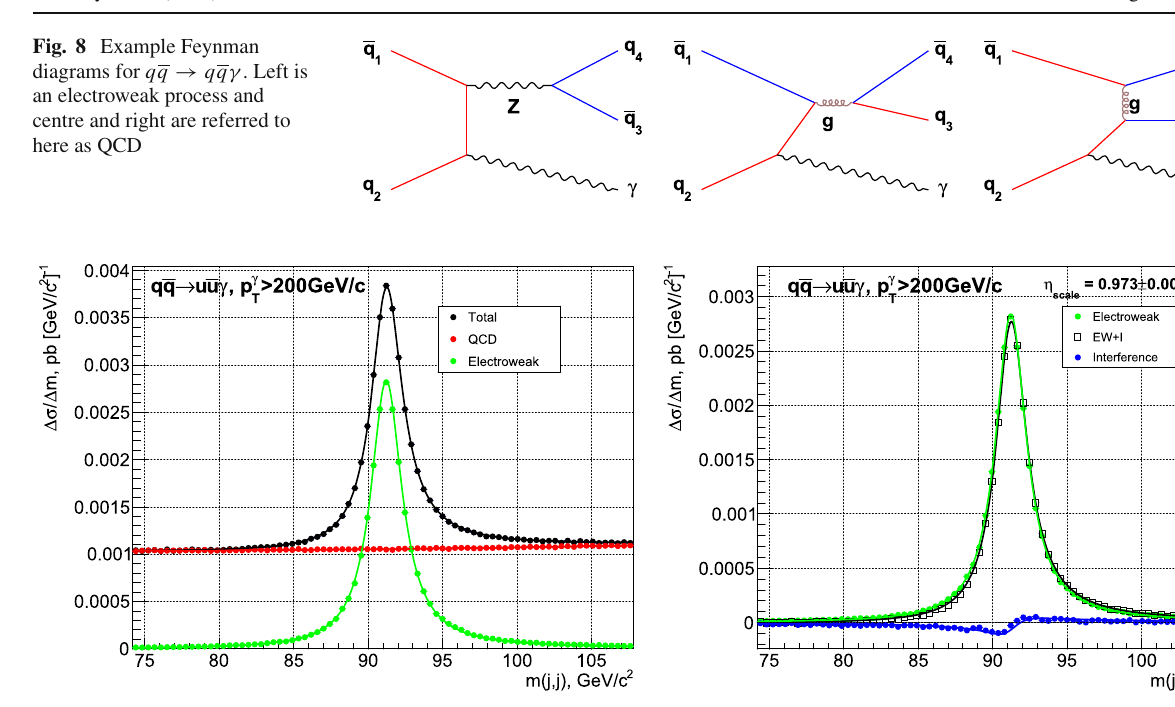
Right has the same electroweak component, but the hollow black points showthetotalminustheQCDcomponent,andthedark/blueistheinter- ference